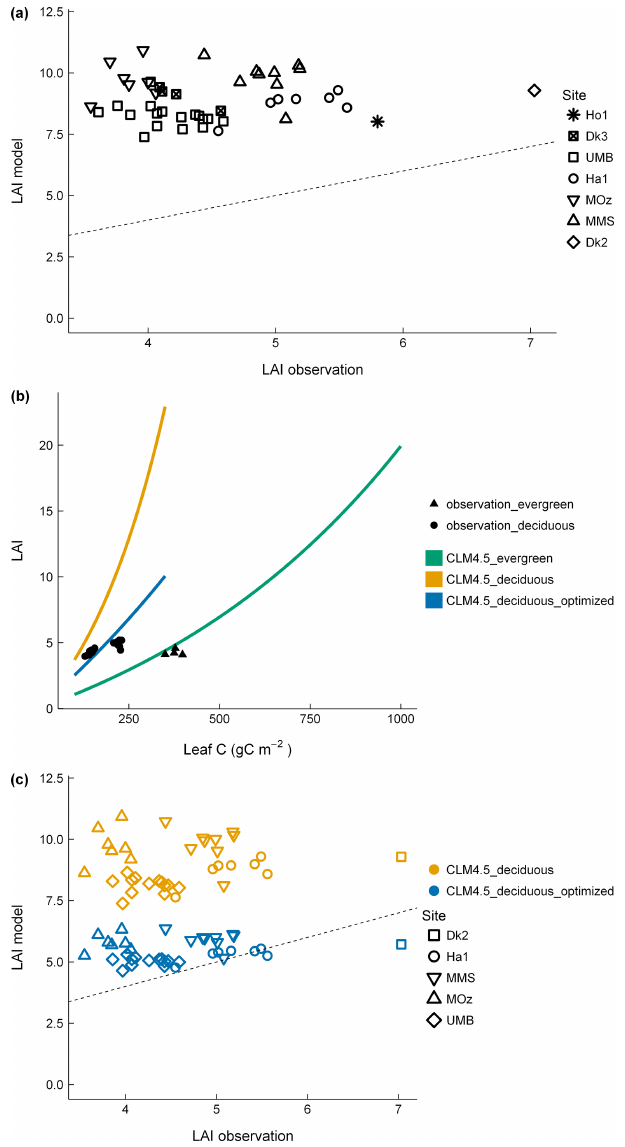
Figure 3. Comparisons between (a) LAI measured in situ and LAI in the model. (b) Relationship between leaf C and LAI in CLM4.5 for deciduous forests, observations for deciduous forests, optimized leaf C–LAI relationship for deciduous forests, CLM4.5 for ever- green forests, and observations for evergreen forests. (c) Compar- isons between LAI measured in situ and LAI in the standard and modified version of the model with optimized parameters for LAI. In (a) and (c) , dashed line is 1 : 1 relationship between observations and model. Observations (LAI measured in situ and leaf C) are from the AmeriFlux database.